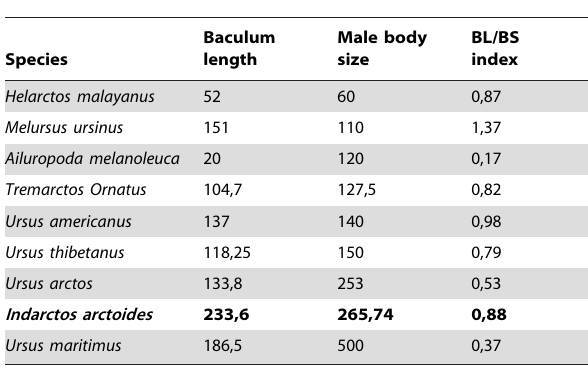
Table 1. Measurements of the baculum length (in mm) and aproximate worldwide average male body size (in Kg) for the eight extant species of Ursidae and the estimated average size calculated for the males of Indarctos arctoides from Batallone-